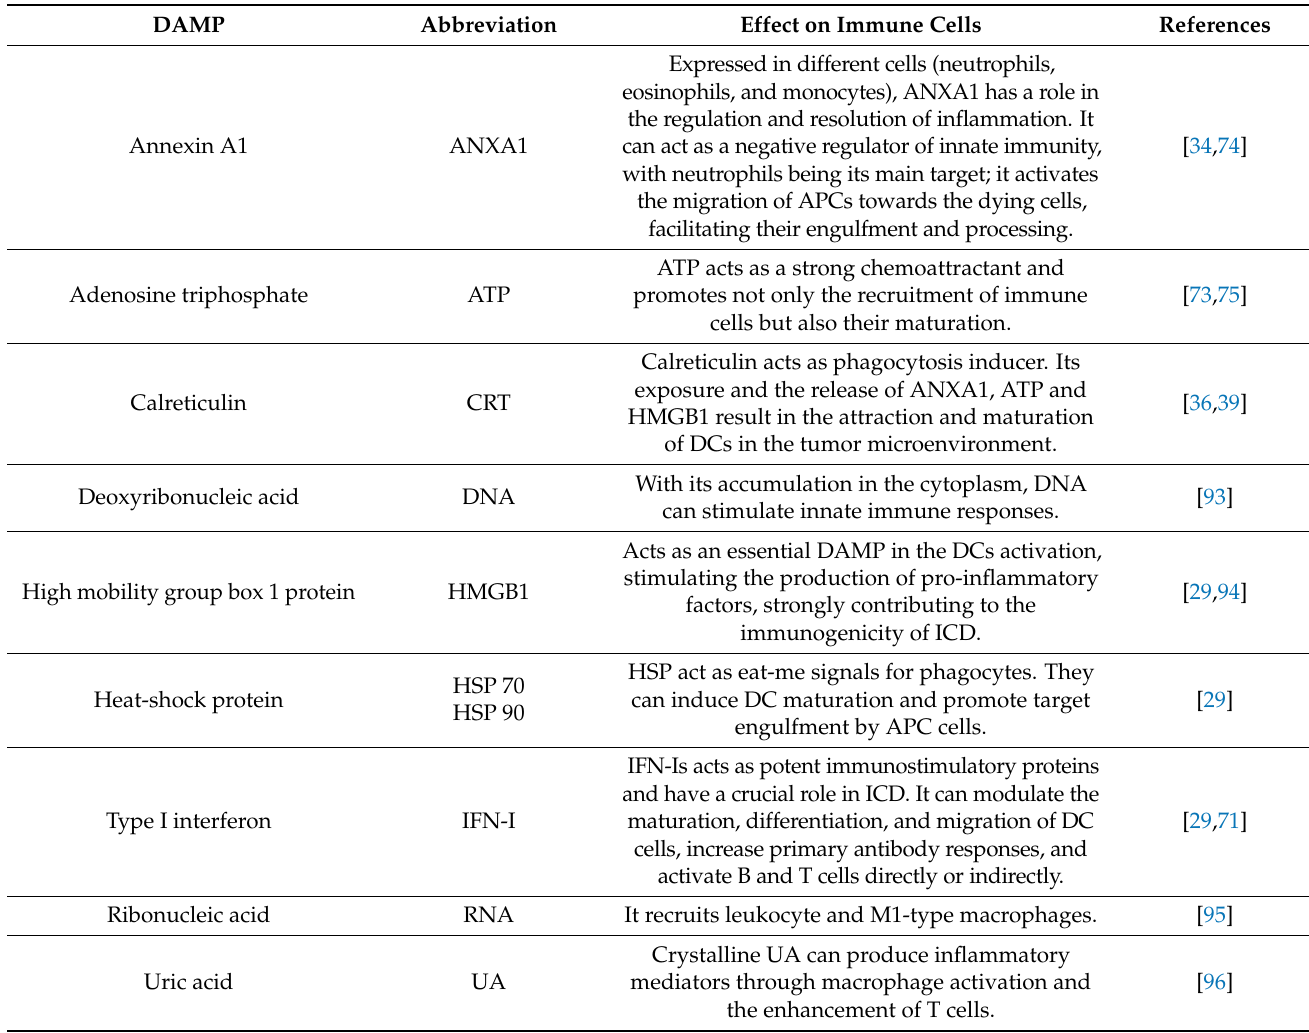
Table 1. Damage-associated molecular patterns involved in immunogenic cell